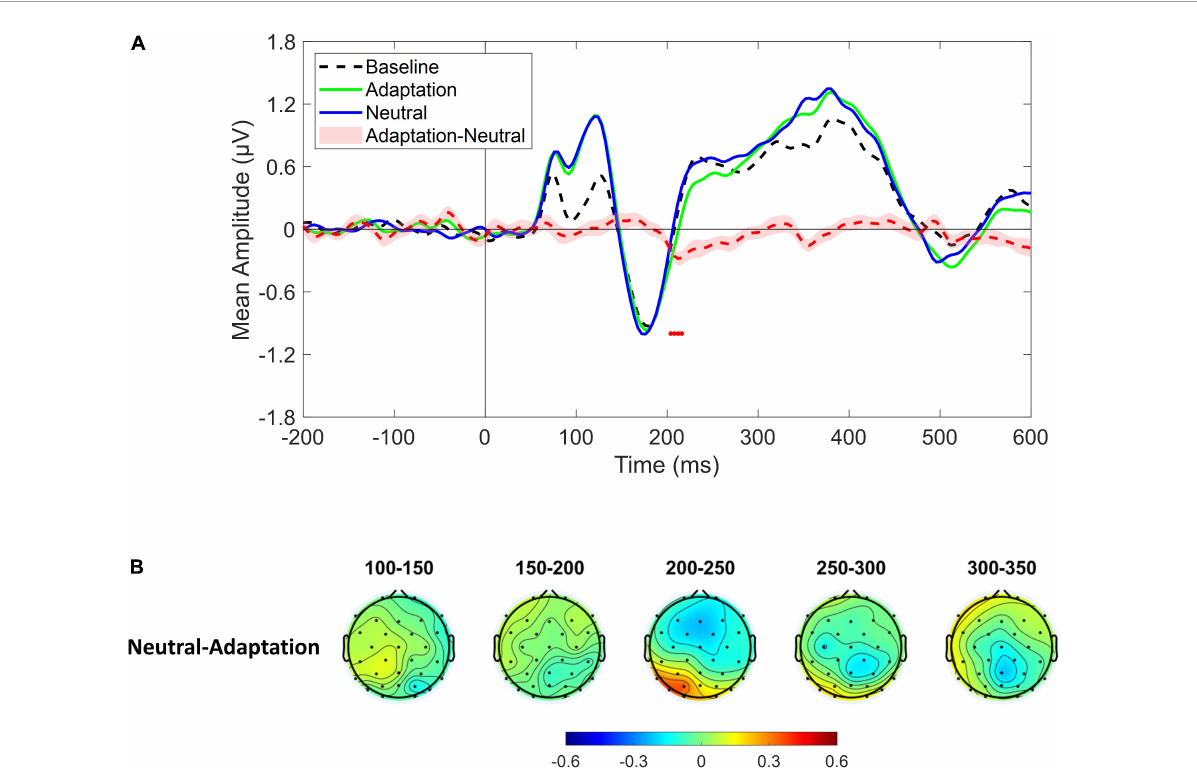
FIGURE3 (A) Event-related potentials (ERPs) response averaged across electrodes P3, P4, P7, P8, PO3, PO4, PO7, PO8, O1, O2 for Baseline (dotted black ERP), Adaptation (green solid ERP), and Neutral (blue solid ERP) conditions. Red dotted curve depicts the temporal distribution of the difference (plus standard error) between Adaptation and Neutral ERP response while red dots depict the time interval of statistical significance. (B) Scalp topographies depicting the spatial and temporal distribution of the difference between Neutral and Adaptation